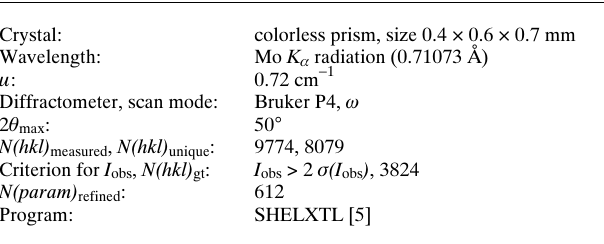
Table 1. Data collection and